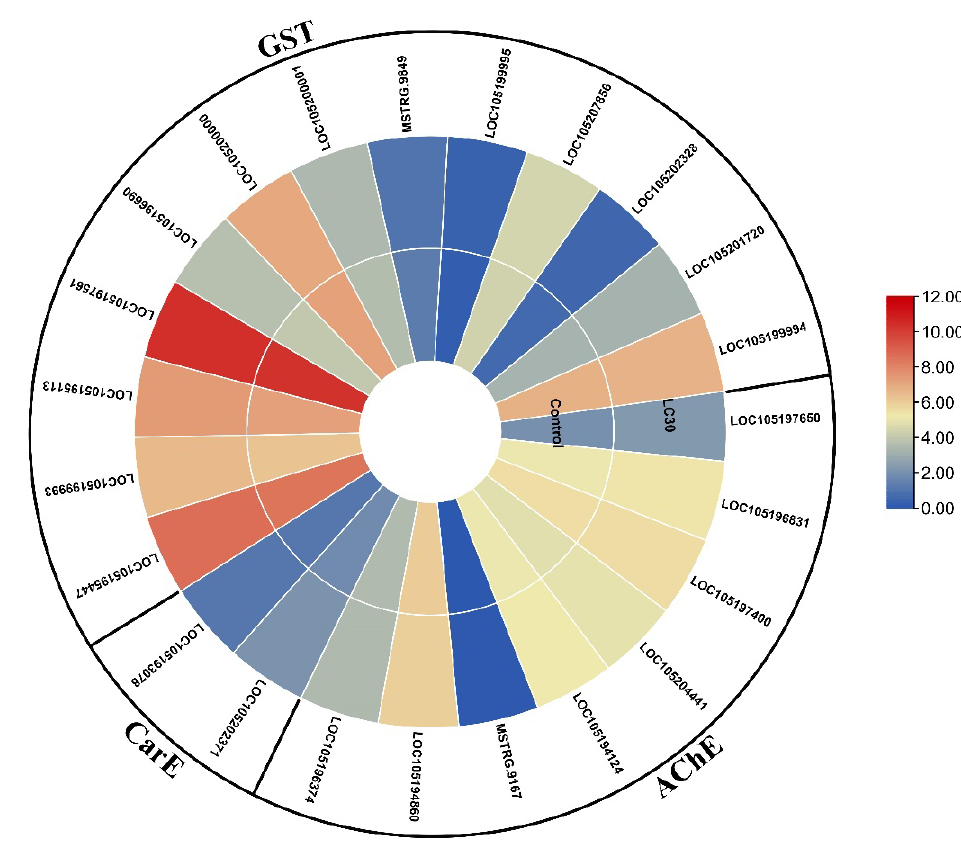
Figure 5. Scheme of the different pathways in the chain affected by the exposure of indoxacarb (after 24 h). The circle’s color indicates the pathway’s function, whereas the strip’s color outside the circle indicates how DEGs are regulated on a scale.